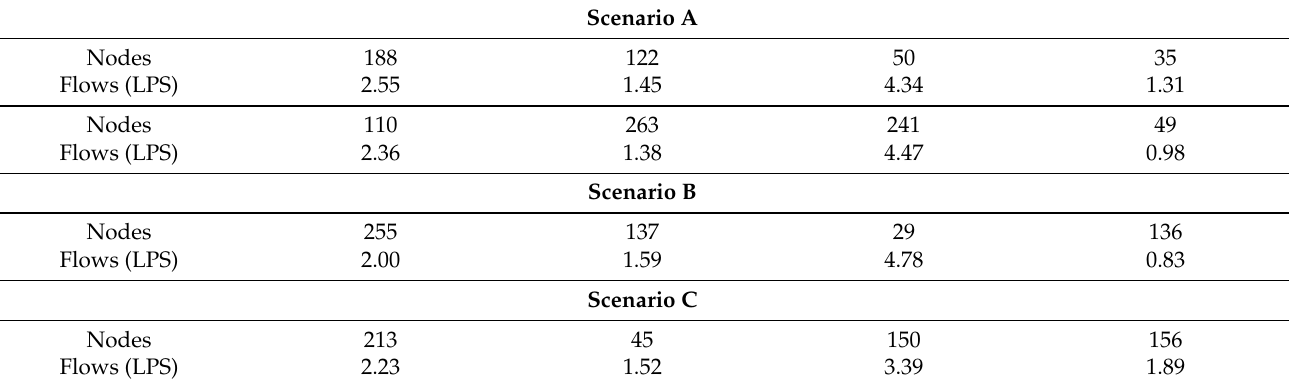
Table 2. Leakage nodes and flow